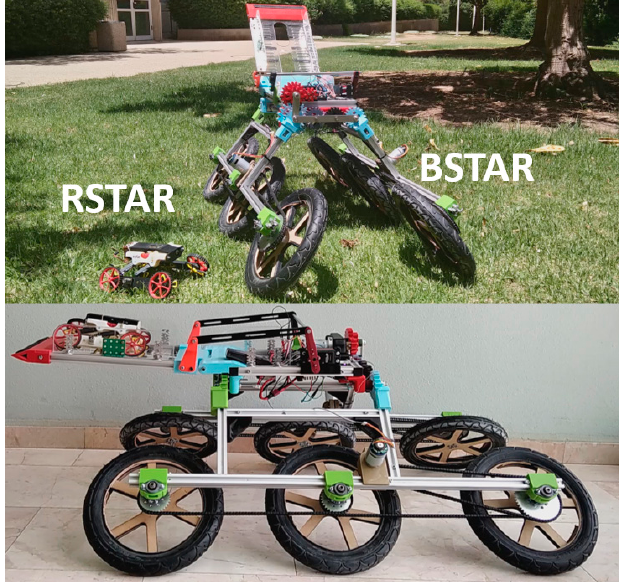
Figure 1. The parent BSTAR robot can carry RSTAR robots and is capable of deploying and recovering them using its actuated tail. The size ratio of the characteristic lengths of the BSTAR to the RSTAR is 6:1.